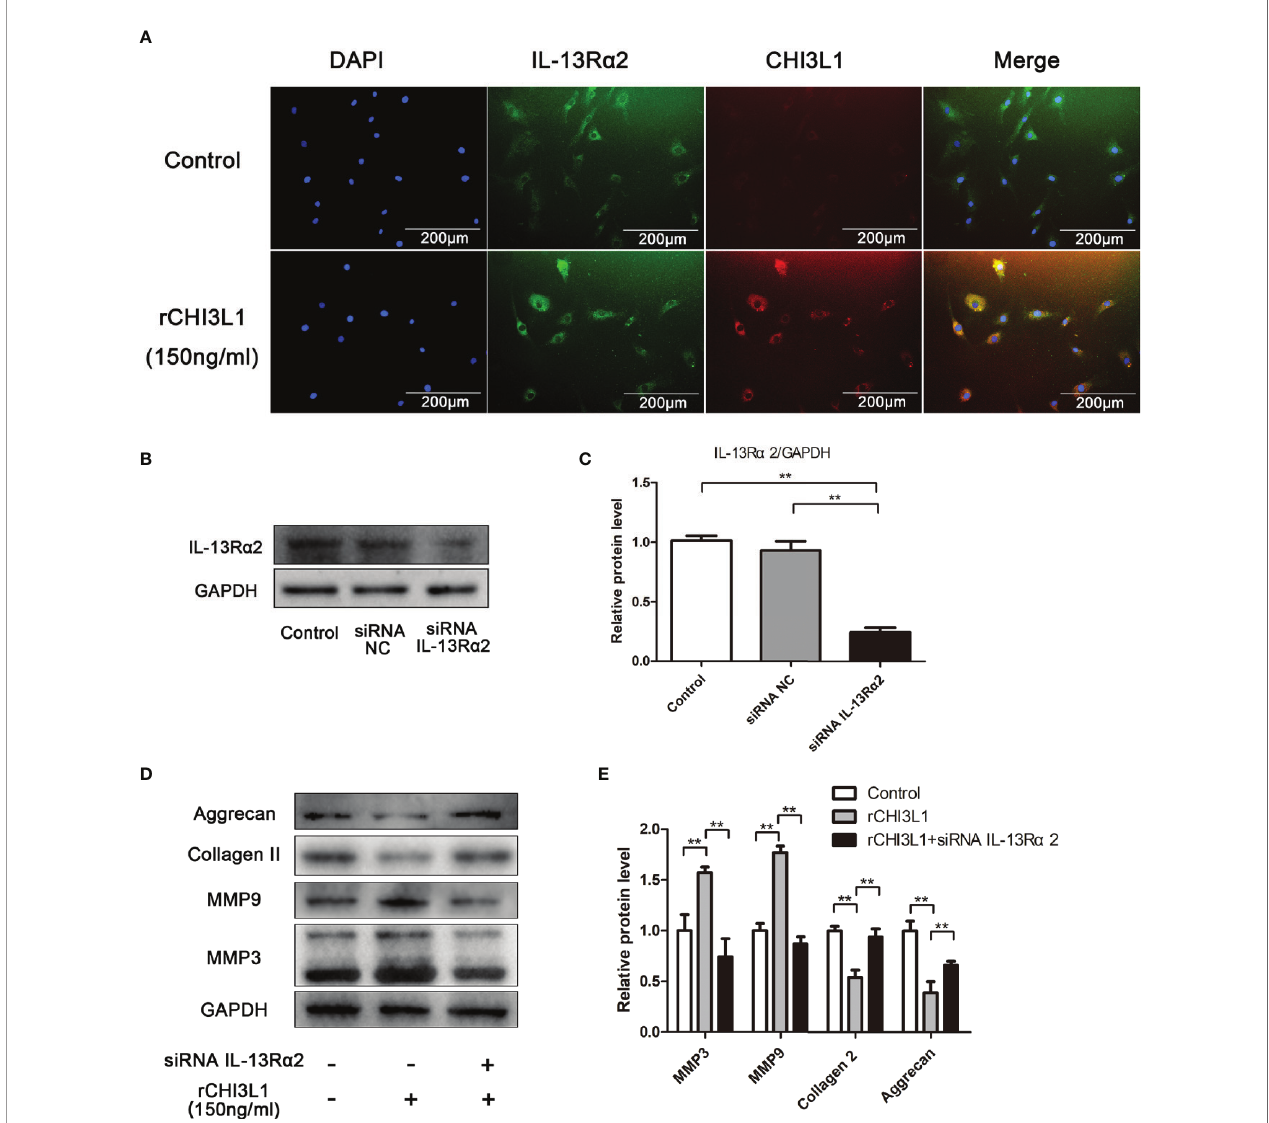
FIGURE 5 | IL-13R a 2 was involved in CHI3L1-induced ECM metabolism. (A) Co-localization of CHI3L1 and IL-13R a 2 proteins in NP cells. After treatment with rCHI3L1 (150 ng/ml) for 24 h double immuno fl uorescence staining was performed on NP cells with anti-CHI3L1 and anti-IL-13R a 2 antibodies. (B) IL-13R a 2 was silenced in NP cells by siRNA. NP cells were transfected with NC siRNA or IL-13R a 2 siRNA, then grown for 24 h. Knockdown of IL-13R a 2 was con fi rmed by western blotting. (C) Quanti fi cation of the protein levels of IL-13R a 2 in western blots. (D) Effects of IL-13R a 2 silencing on CHI3L1-induced ECM metabolism. After transfecting with NC siRNA or IL-13R a 2 siRNA for 24 h, NP cells were incubated with rCHI3L1 (150 ng/ml) for another 24 h. The protein levels of MMP3, MMP9, collagen II, and aggrecan were detected by western blotting. (E) Quanti fi cation of the protein levels in (D) . Data are presented as means ± standard deviations (n = 3) from one representative experiment of three independent experiments performed in triplicate. The dates were analyzed by One-way analysis of variance (ANOVA). Signi fi cant differences between groups are shown as **p <